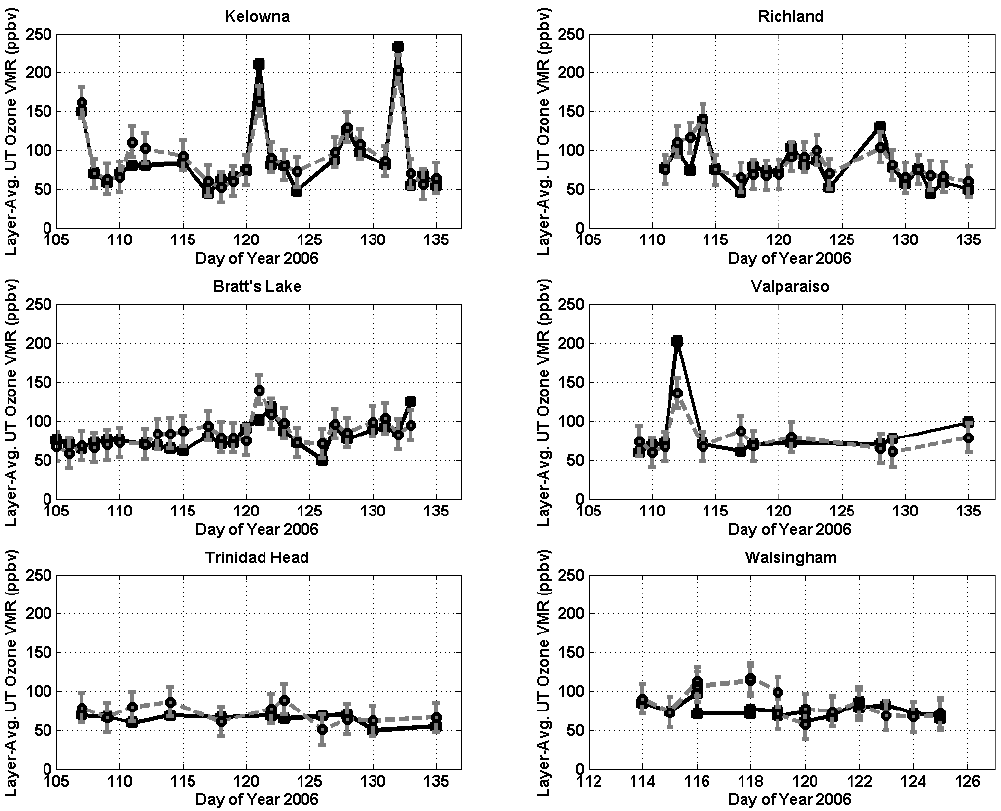
Fig. 3. Time series of MUTOP layer-average UT ozone VMR estimates (circles with grey dashed lines and RMS error bars) and corresponding ozonesonde layer-average UT ozone VMR measurements (squares and black solid lines) for the six ozonesonde stations with more than ten launches during the INTEX-B study